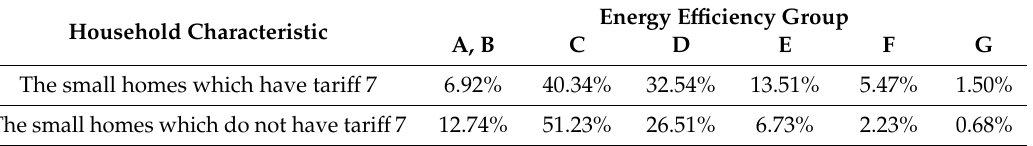
Table 5. The percentages of homes located in di ff erent energy e ffi ciency